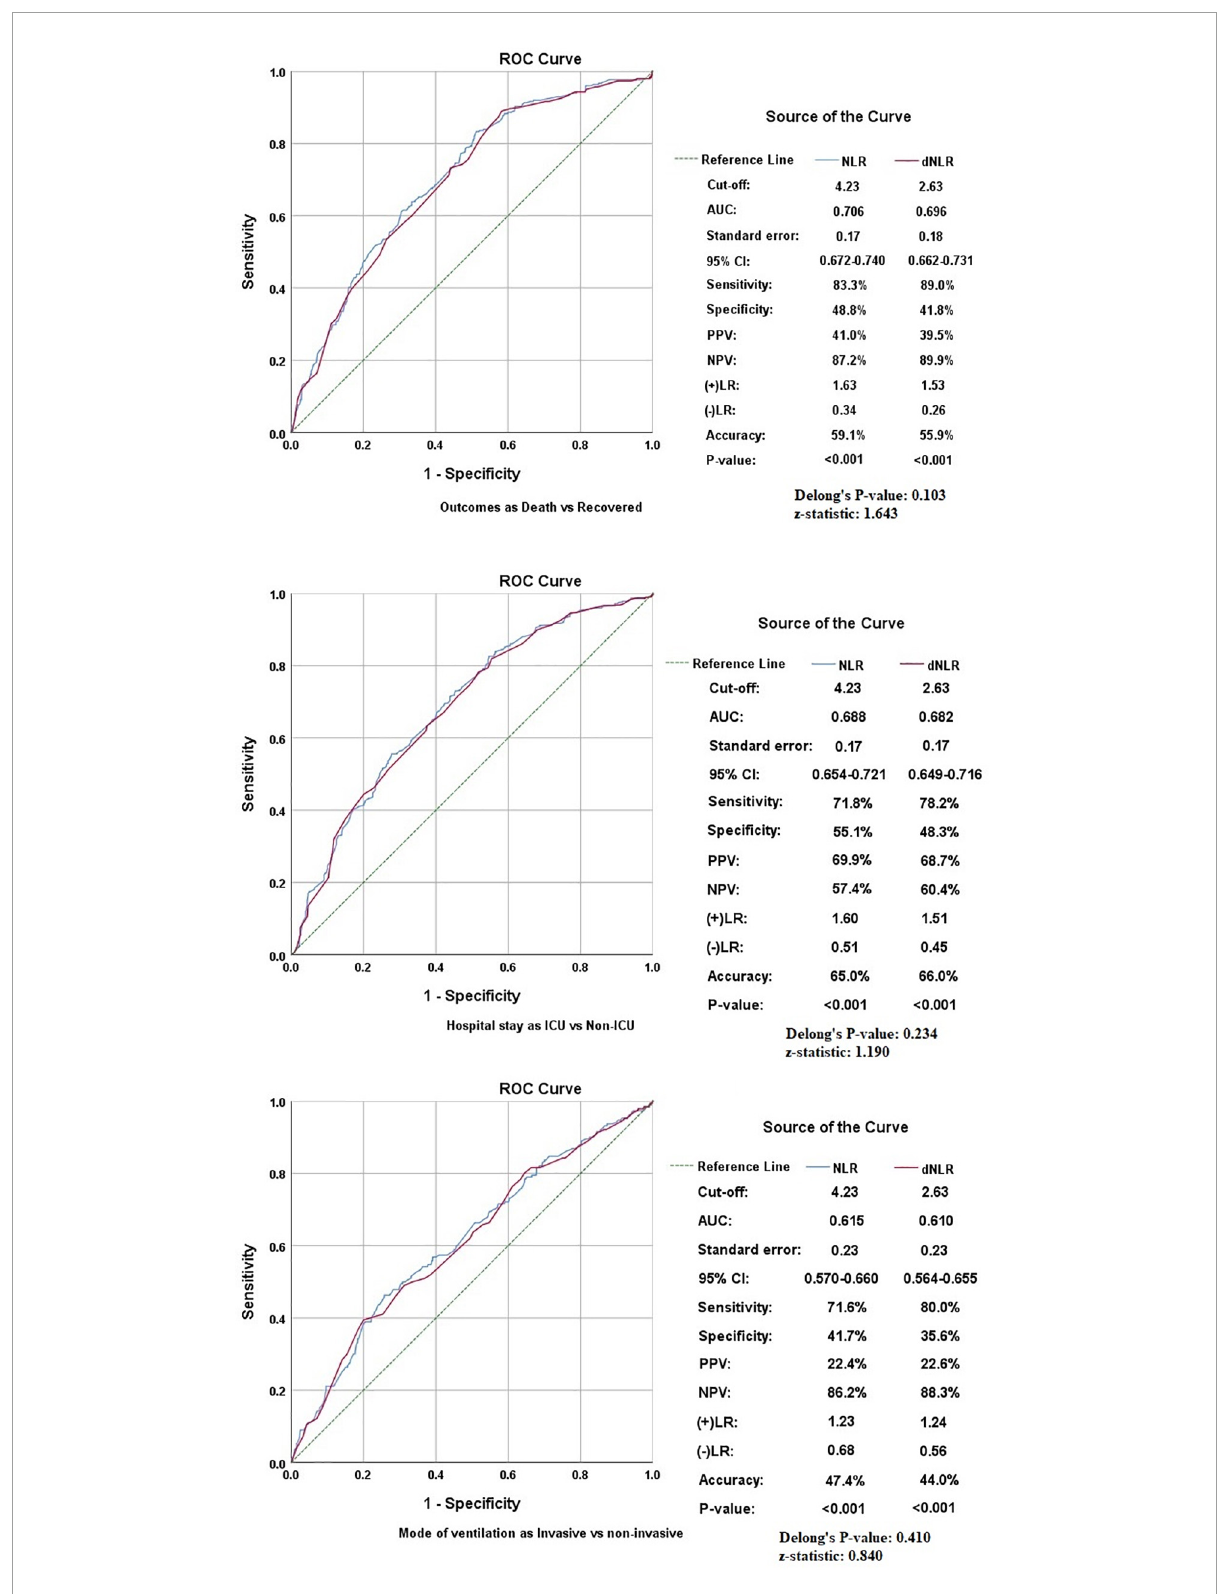
FIGURE3 Receiver operating characteristics (ROCs) showing the association of neutrophil to lymphocyte ratio (NLR) and derived NLR (dNLR) with study variables.